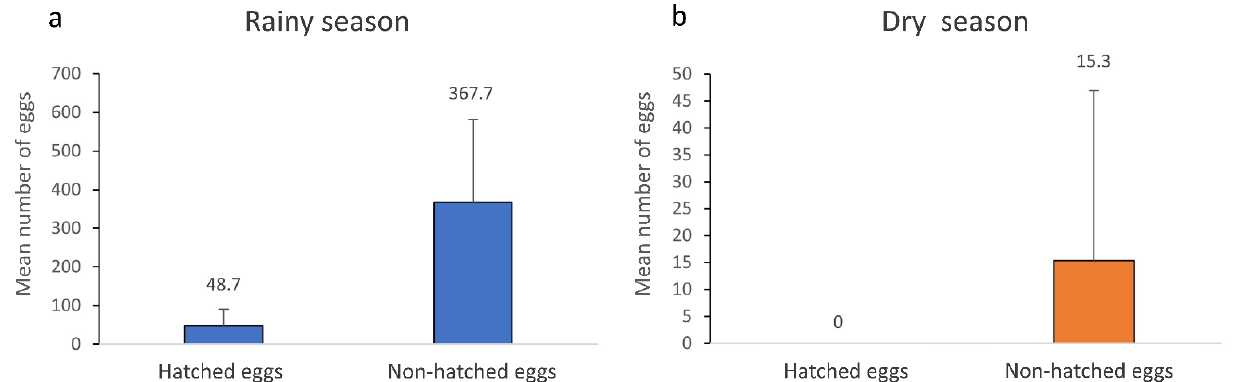
Figure 3. Mean and standard deviation of the number of hatched and non-hatched eggs from all Culicidae species collected from June to September 2020 in the RPPN Gaviões in the rainy ( a ) and dry ( b ) seasons.